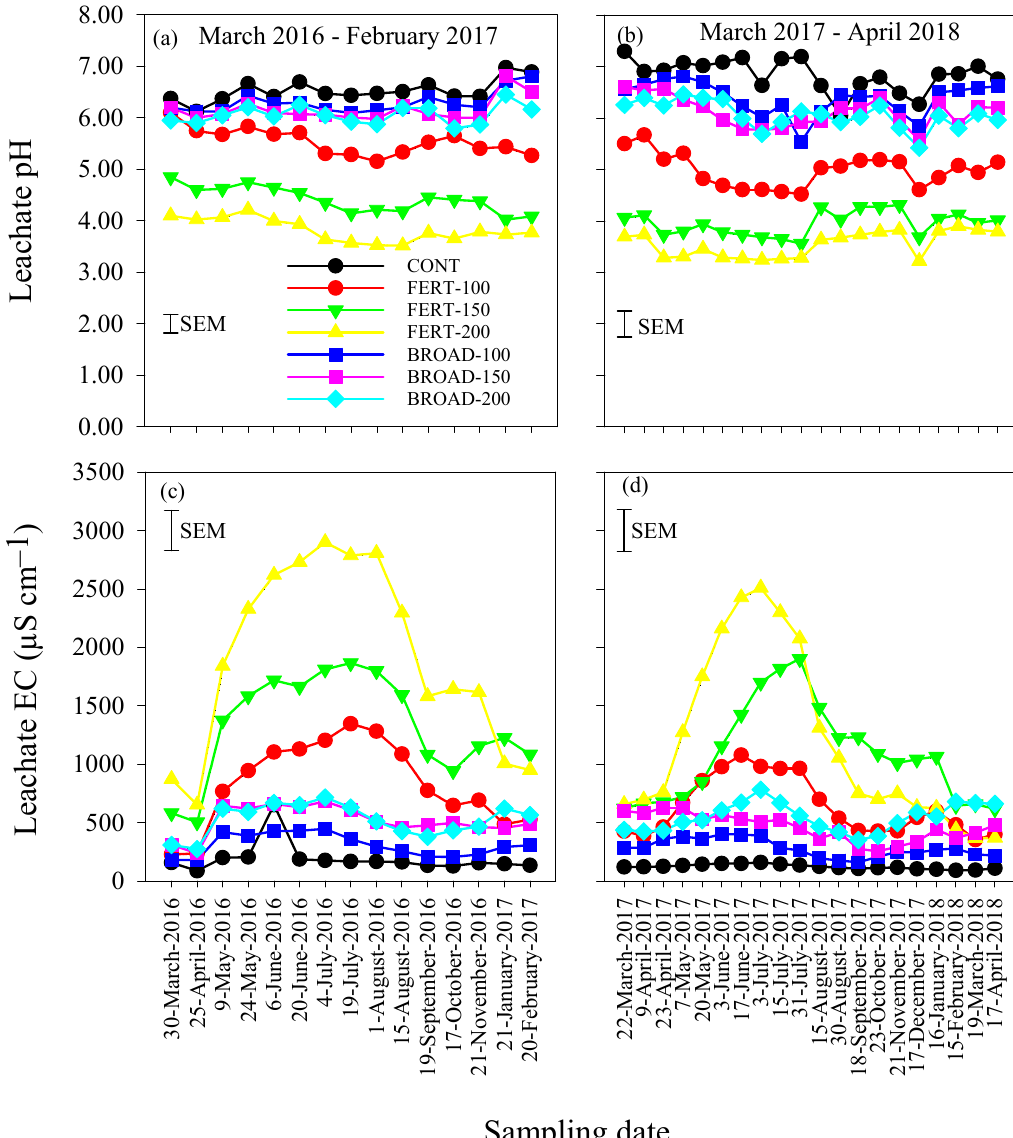
Figure 3. ( a , b ) Acidity (pH) and ( c , d ) electrical conductivity (EC) of leachate collected at 76 cm soil depth with annual applications of N through fertigation (FERT-100, 100%; FERT-150, 150%; FERT-200, 200%) and broadcast (BROAD-100, 100%; BROAD-150, 150%; BROAD-200, 200%) methods to